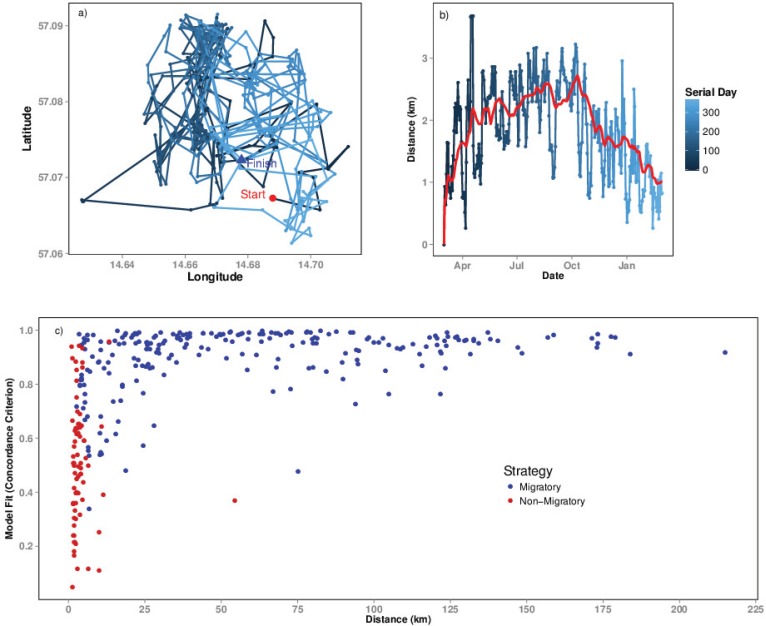
Classifying small-scale migrations.a) A movement trajectory and b) Net Squared Displacement (NSD) plot for an individual moose migrating a short distance. The coloured lines represent the movement over time, for both the xy path (a) and the NSD (b), whilst the red line indicates the MSD averaged over 30 time steps. It is evident from the deviations of the movement trajectory from the MSD, that for small-scale migrations, it is difficult to discriminate daily movements from migratory movements as these may operate over similar spatial scales. The MSD helps smooth the daily movements, thus improving the model fitting process, however, there is no easily identifiable summer range in comparison to Fig 1. c) Best Concordance Criterion (CC) value fitted against asymptote (scale of movement in kilometres) for moose classified as migratory (n = 299). Blue points indicate moose that were confirmed as migratory (n = 226) whereas red points indicate moose that had been misclassified as migratory (n = 73), as they were in fact non-migratory following visual inspection. The misclassified individuals had smaller scales of movement, and generally lower CC values. In addition, moose migrating at smaller scales (<10km) generally had poorer model fits in comparison to moose migrating at larger scales (>10km).